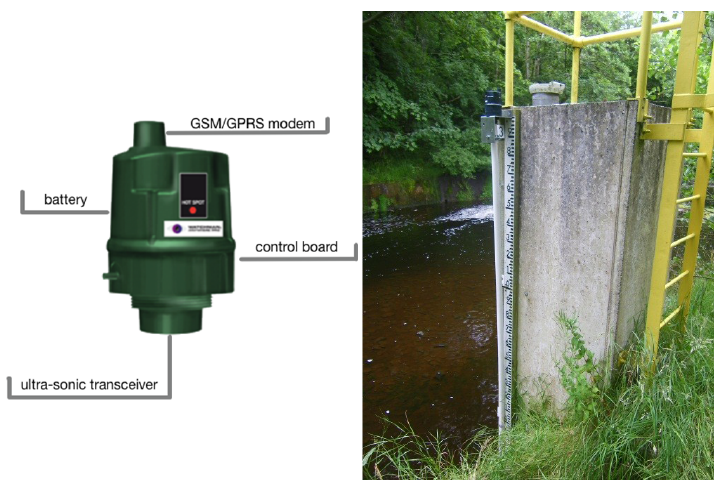
Figure 3. Kingspan Sonic SignalMan ultra-sonic sensor ( left ) and the sensor deployment at the Bohernabreena site ( right ).